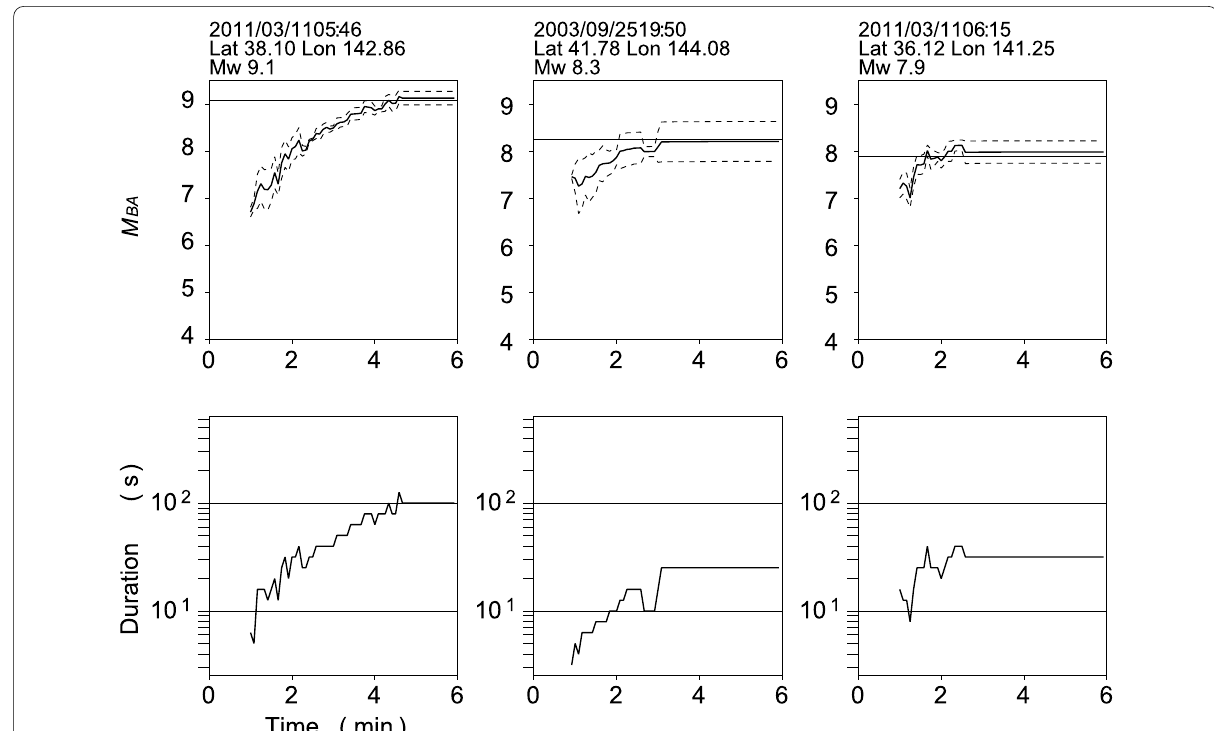
Fig. 12 Variations of the magnitude ( M BA ) (upper graph) and duration (lower graph) estimated from observed data in relation to elapsed time from the origin for three large earthquakes around the Japanese Islands ( the 2011 Tohoku earthquake M w 9.1 ; the 2003 Tokachi-oki earthquake M w 8.3 ; the largest aftershock of the 2011 Tohoku earthquake M w 7.9 ). On the magnitude graphs, the horizontal lines indicate M w and dashed lines M w standard deviation of estimated station ±